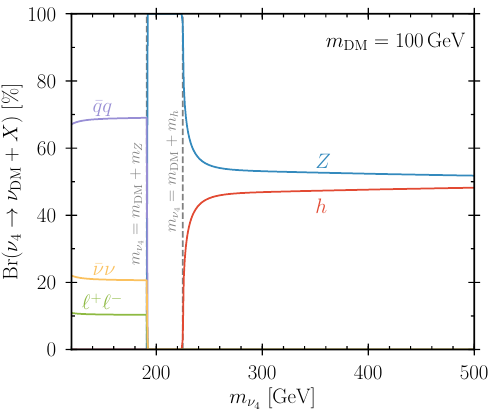
Figure 12 . Branching ratios of the neutral heavy lepton, assuming m e 0 : 01, and a DM mass of 100